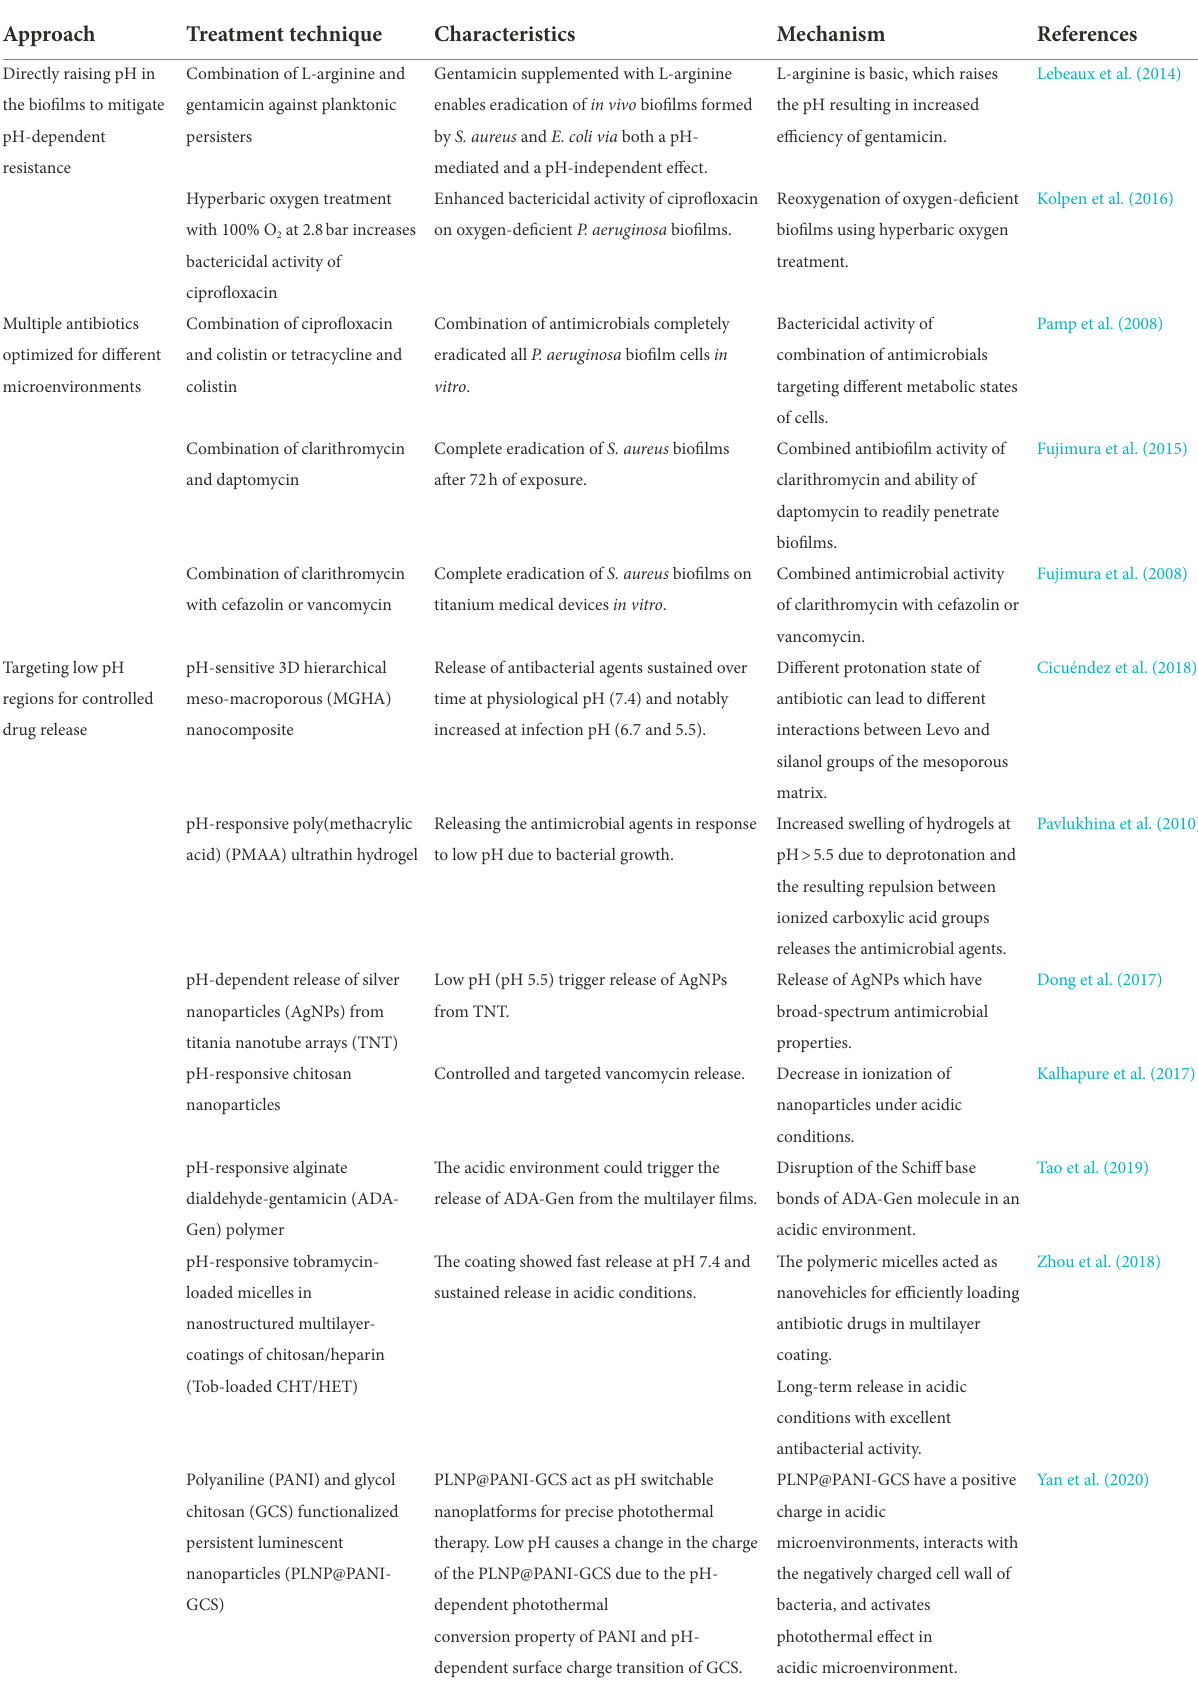
TABLE 4 Summary of various studies on treatment of